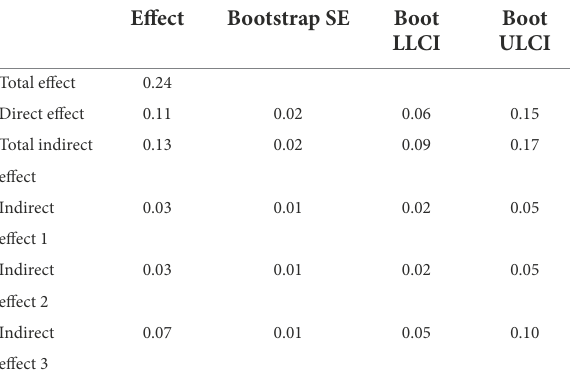
TABLE 3 Effects and 95% confidence intervals for